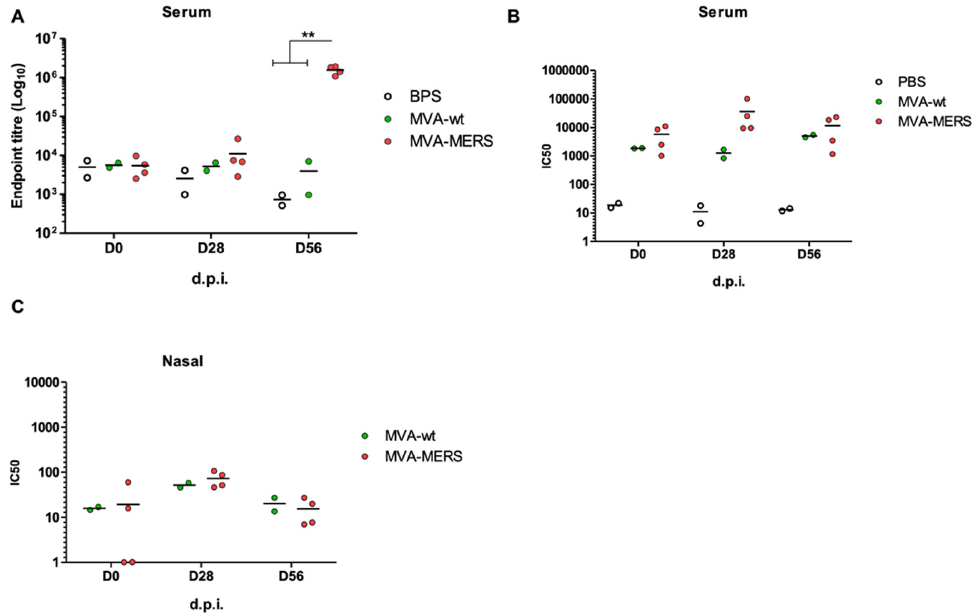
Figure 3. Humoral immunogenicity of homologous MVA-MERS prime–boost vaccination in dromedary camels. Camels (n = 4) were intramuscularly immunised with 1 × 10 9 PFU. Other camels were immunised with similar dose of MVA-wt (n = 2) and PBS (n = 2). Serum samples were collected pre-vaccination at 0 d.p.i, at 28 d.p.i (post-prime), and 56 d.p.i (post-boost). Anti-MERS-CoV spike antibodies were measured with ELISA at all time points, reported as Log10 endpoint titres ( A ). Neutralisation activity of antibodies was confirmed via MERSpp neutralisation assay for serum ( B ) and nasal swab ( C ) samples collected at all time points, presented as the sample dilution that showed inhibitory concentration of 50% of the pseudoviruses (IC50). Mean values are shown as lines. ** indicates p value < 0.002 by one-way ANOVA test and Bonferroni’s multiple-comparison post-test.